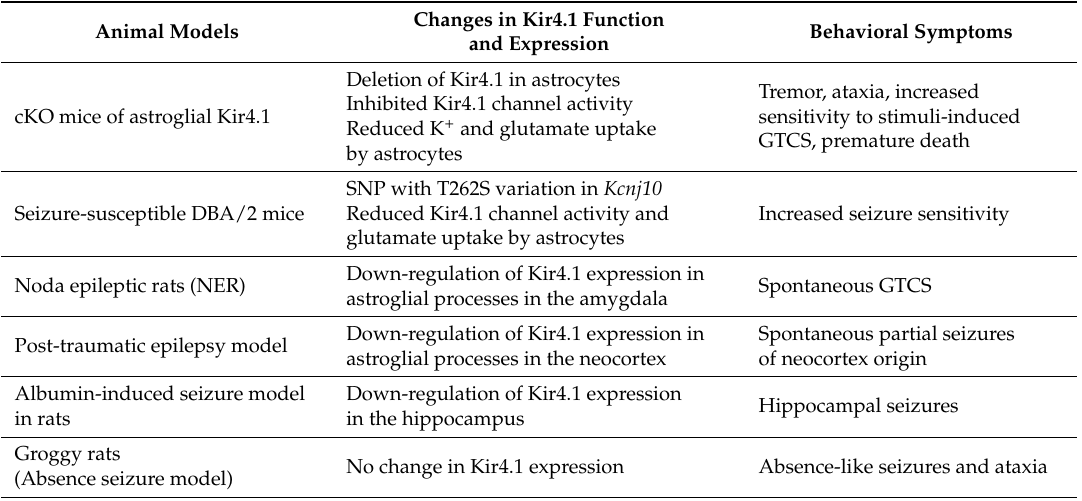
Table 1. Pathophysiological alterations of astrocytic Kir4.1 channels in animal models of epilepsy.